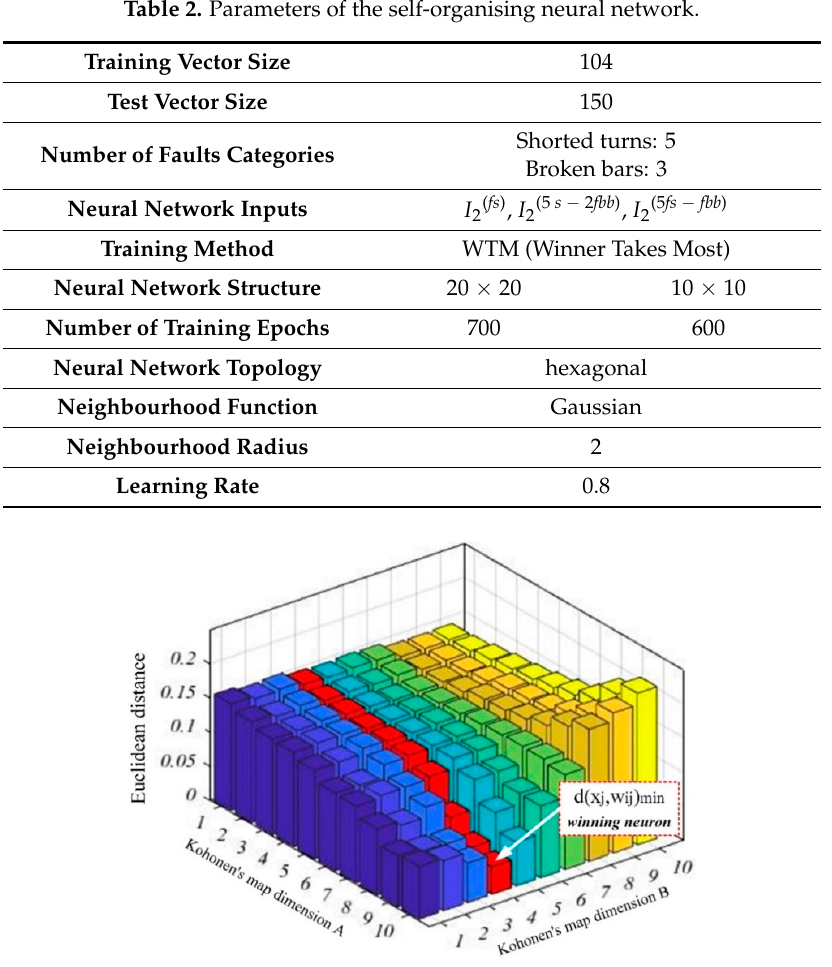
Table 2. Parameters of the self-organising neural network.